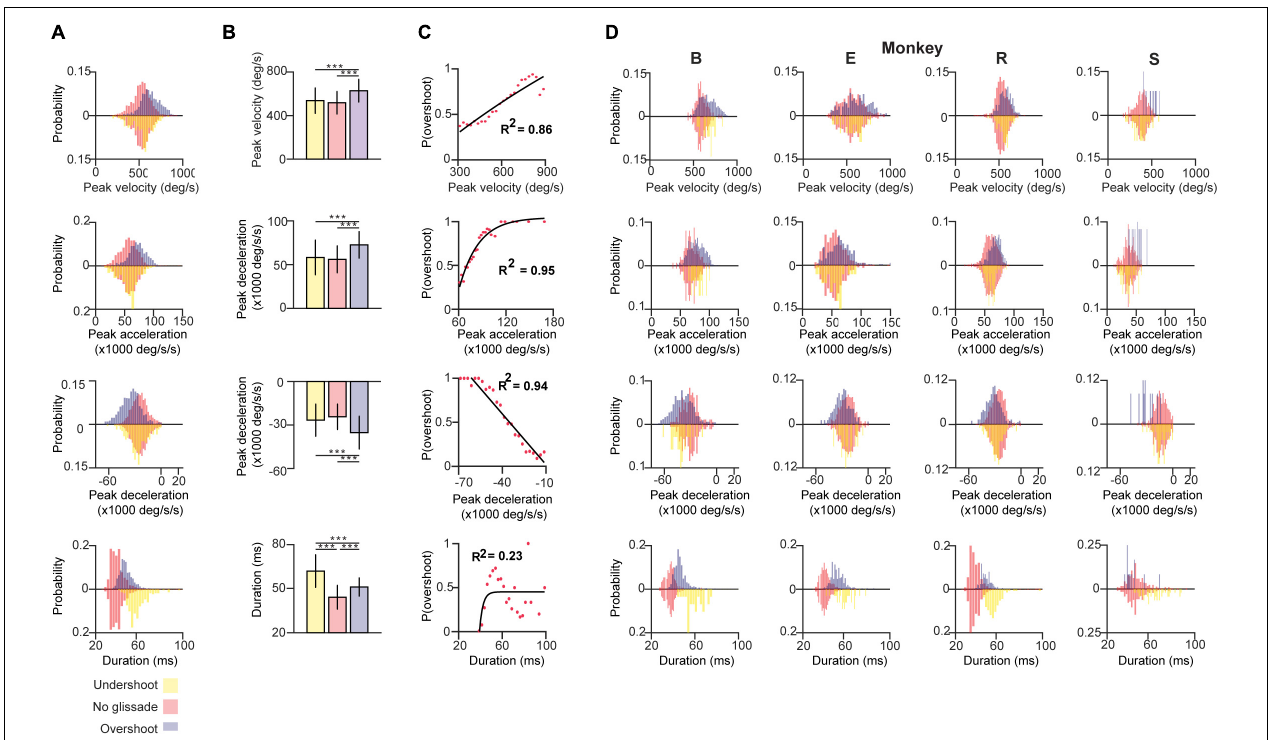
FIGURE 3 | Kinematics of saccades with undershoot, overshoot or no glissade. (A) Probability density histograms of saccade kinematics of all animals combined. Red bars represent kinematic parameters of saccades without a glissade, purple bars represent saccades with glissadic overshoots and yellow bars saccades with glissadic undershoot. Red up and downward bars represent the same data to clearly compare the effect of undershoots and overshoots. (B) Average kinematics of saccades from all animals with glissade ± SD. (C) Linear or exponential regression analysis on the probability of having a saccadic with overshoots and kinematic parameters. (D) Histograms of the same kinematic parameters as represented in (A) for individual animals. “B,” “E,” “R,” and “S” denote each of the four monkeys. ‘ ∗∗∗ ’ symbols denote p -values of < 0.001.